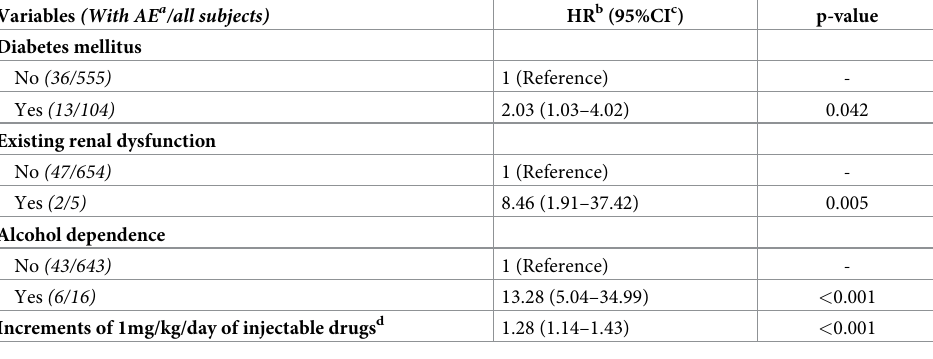
Table 4. Multivariate analysis for risk factors associated with the occurrence of nephrotoxicity. Variables (With AE a /all